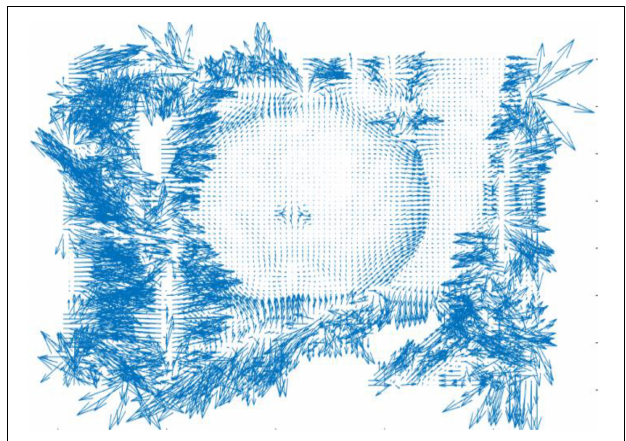
FIGURE 4 | Two-dimensional plane projection of gradient field.